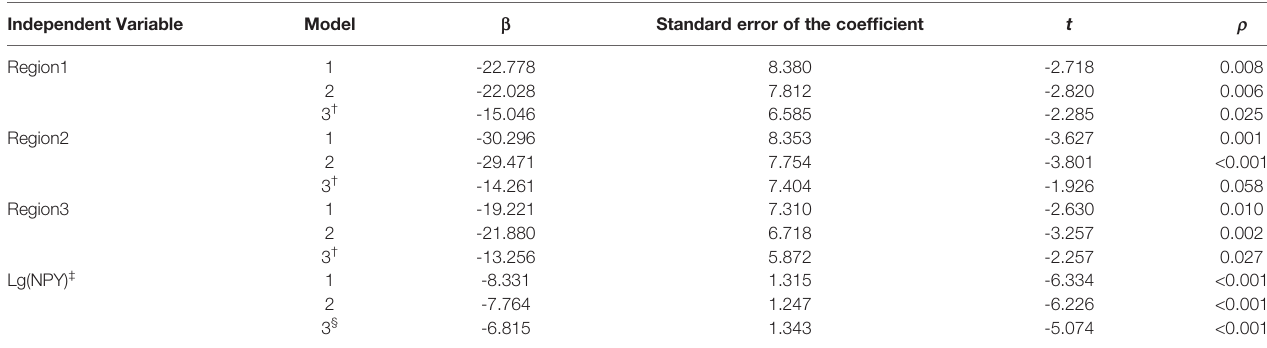
TABLE 4 | Multiple linear regression models for associations of brain glucose metabolism and NPY with the activity of BAT*. Independent